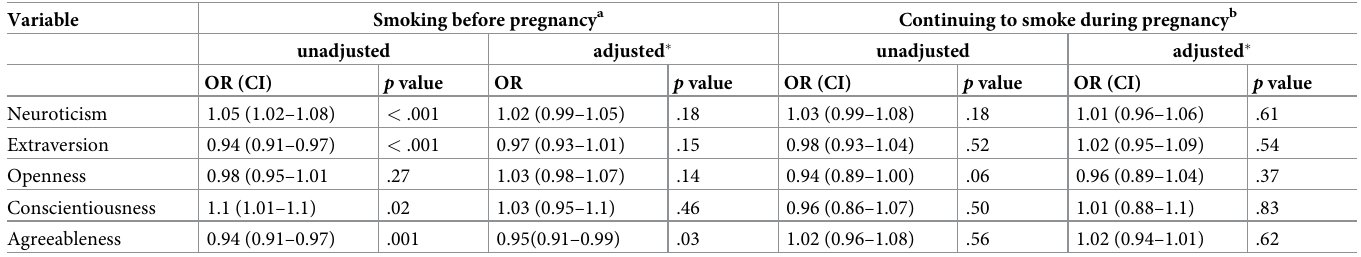
Table 2. Associations between women’s personality and smoking before and during